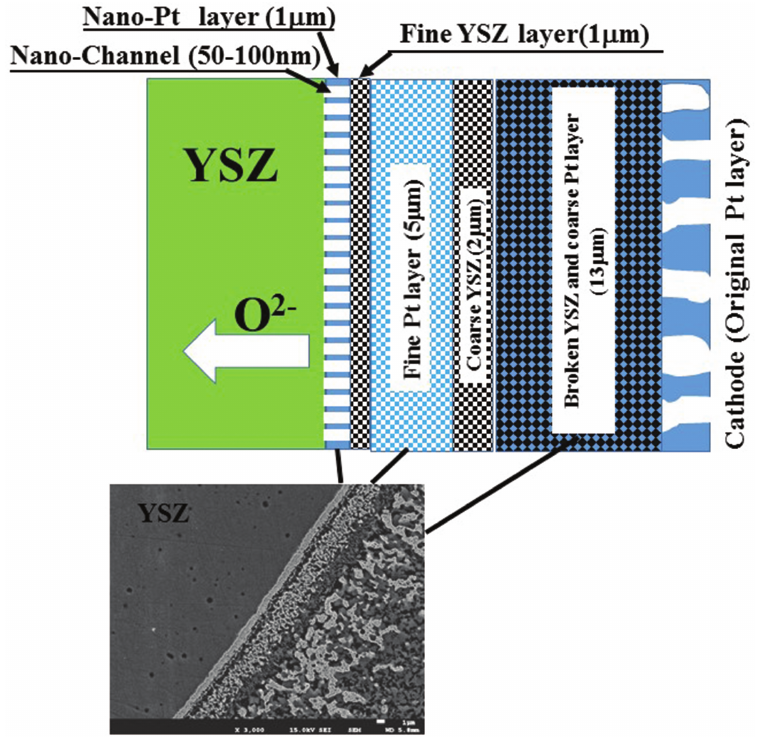
Figure 11: Illustration of nano-structure in the interface between the Pt electrode and YSZ in cathode after the experiment (maximum potential: 4 V).